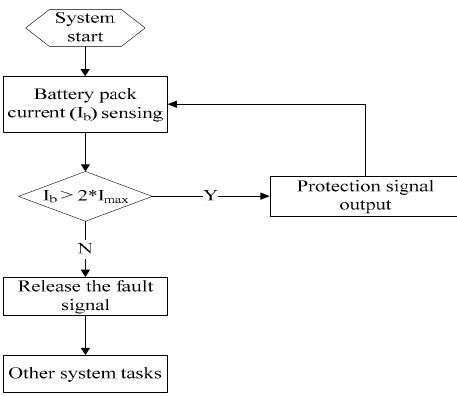
Figure 5. Diagram of the digital diagnosis and protection scheme for external-fault diagnosis.